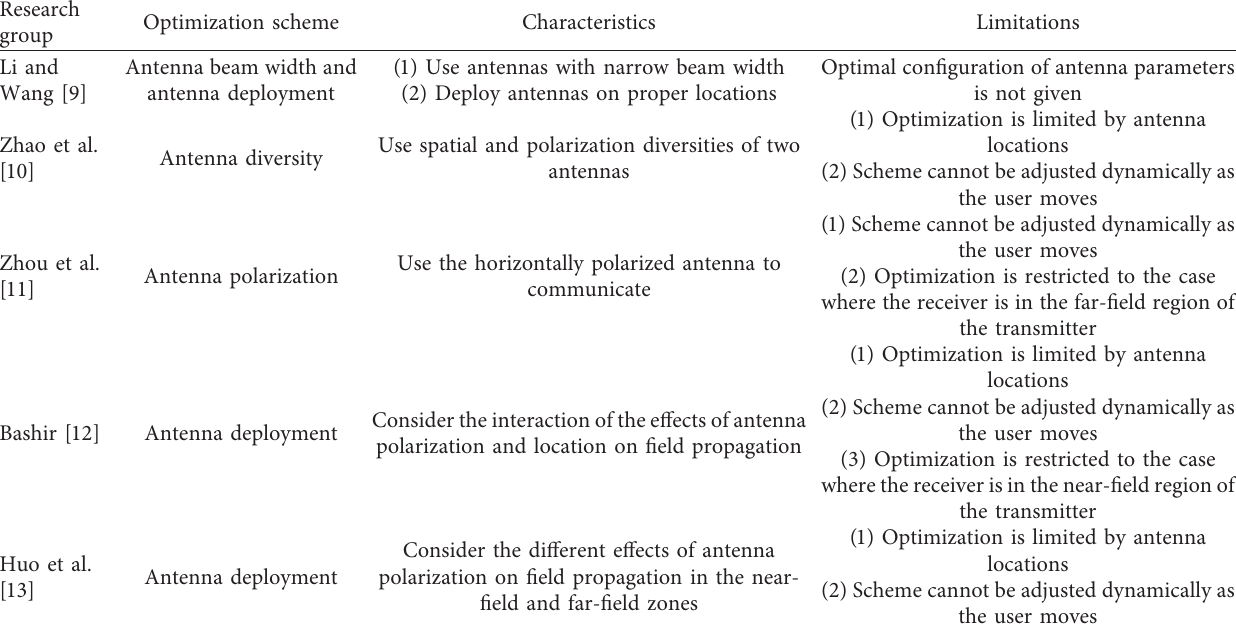
Table 1: Examples of wireless coverage optimization scheme in underground